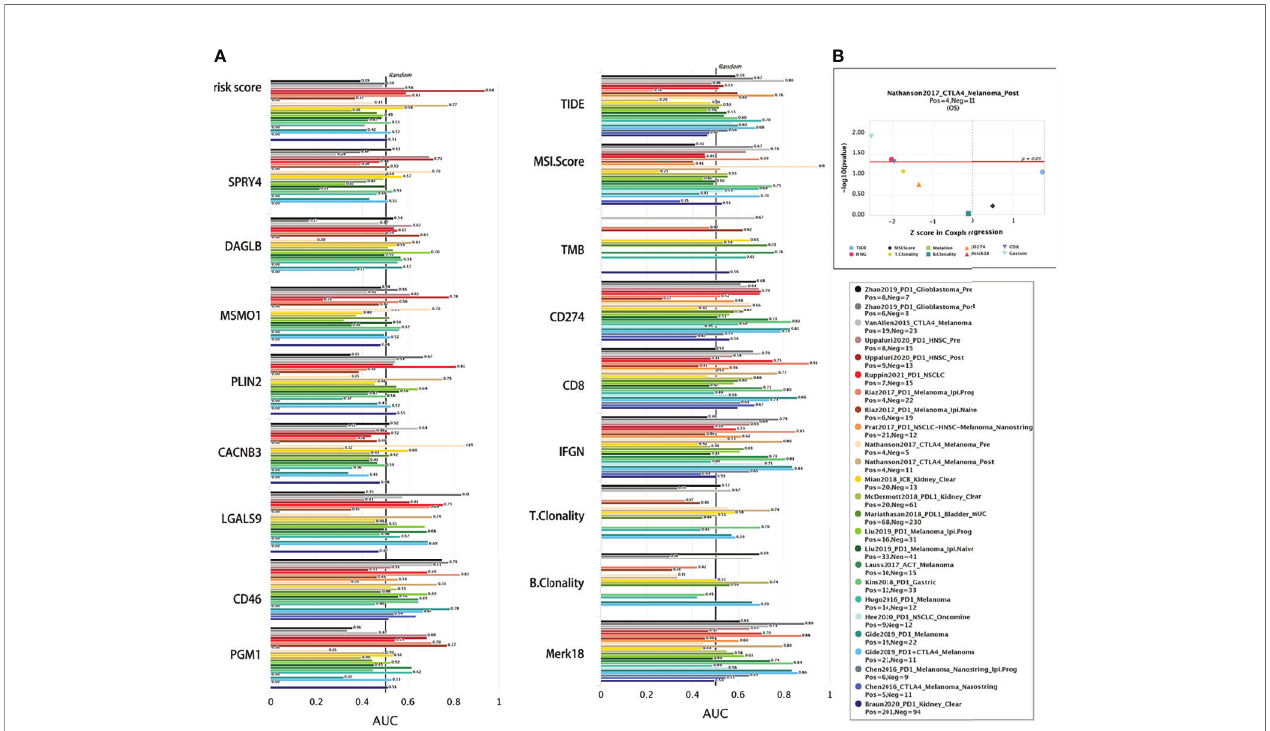
FIGURE 12 | Comparison of immunotherapy response. (A) The immunotherapy response of risk signature and related genes were compared with the immune checkpoint blockade response status biomarkers by AUC in TIDE web. (B) The eight gene signature is association with overall survival of melamoma patients treated in CTLA4 (by two-sided Wald